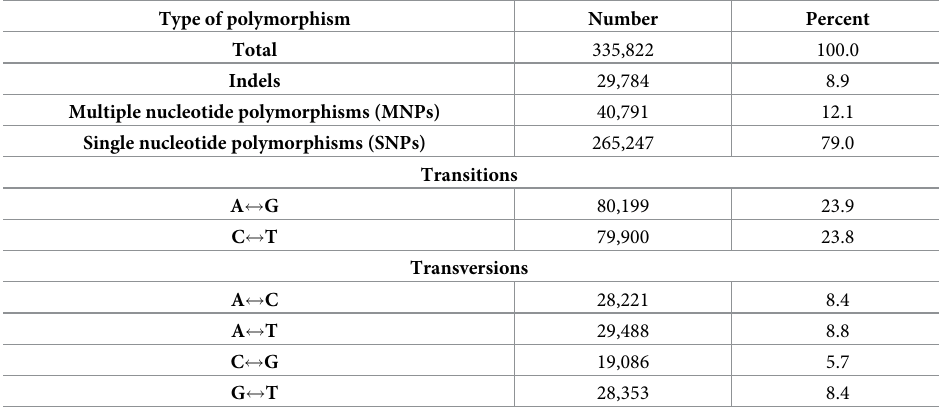
Table 2. Statistics of sequence polymorphisms identified in population 398 of table